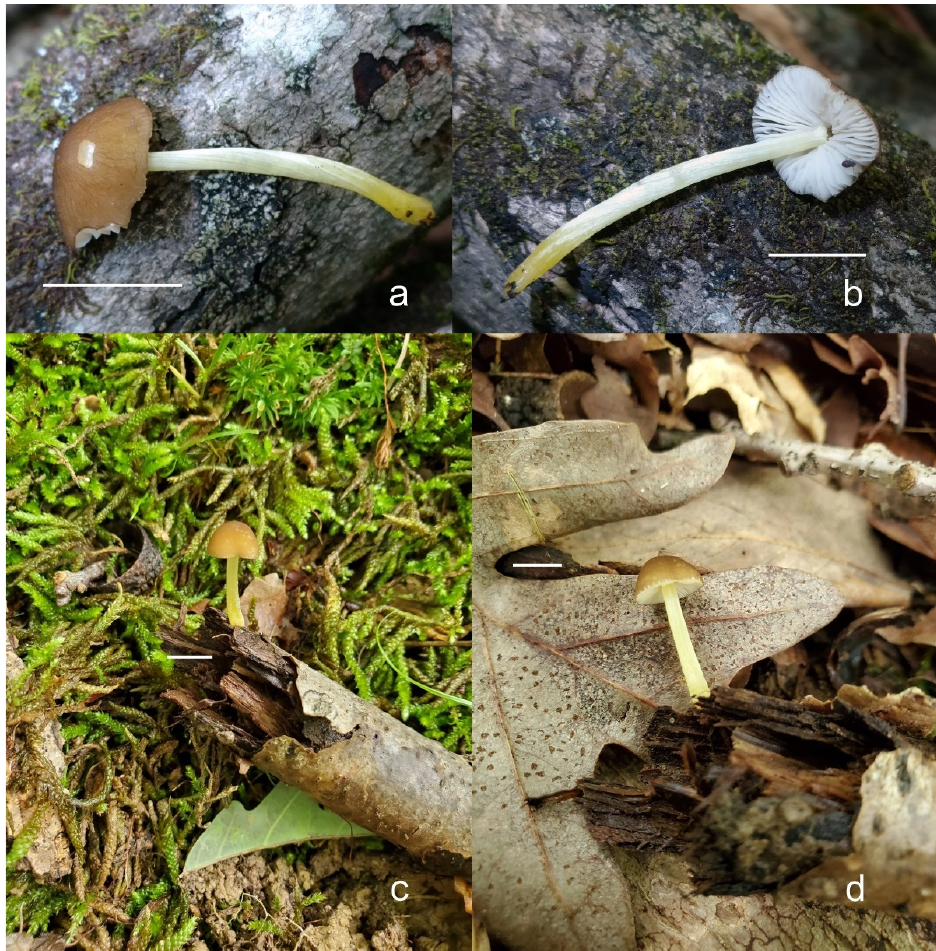
Figure 12. Pluteus parvisporus basidiomata in situ: ( a , b ). iNaturalist 112236342 (holotype), ( c , d ). iNaturalist 27586123. Scale bars 1 cm.